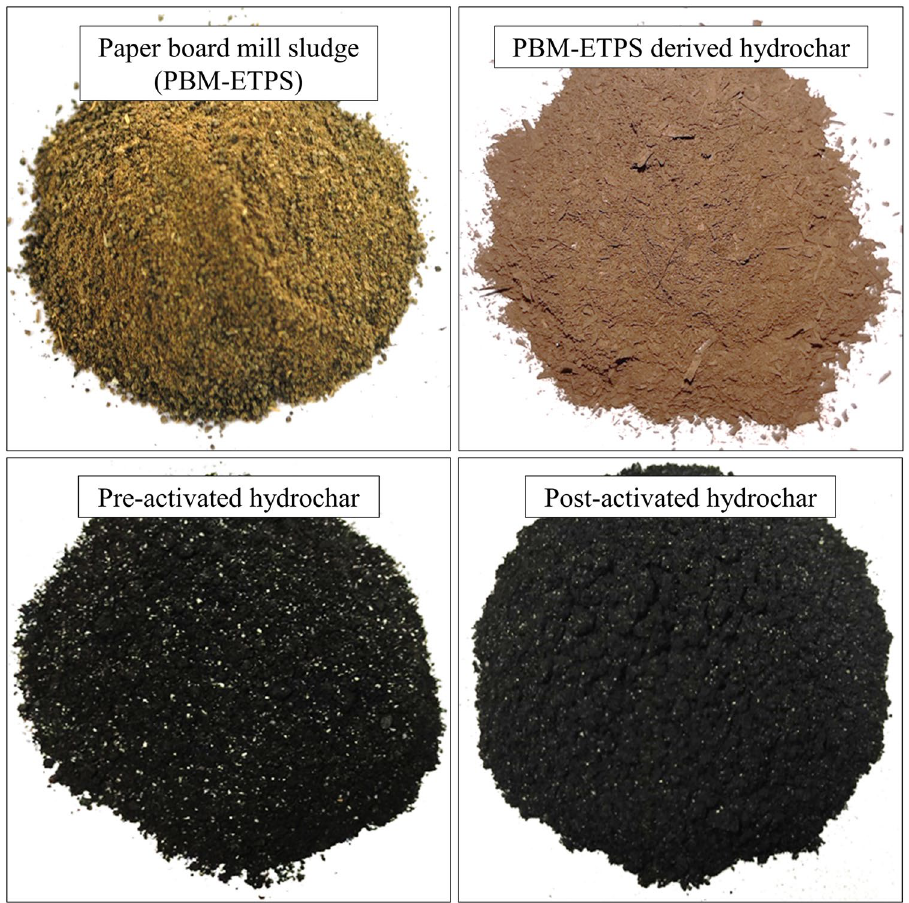
Figure 2. Visual interpretation of Paper board mill ETP sludge and its derived hydrochars.